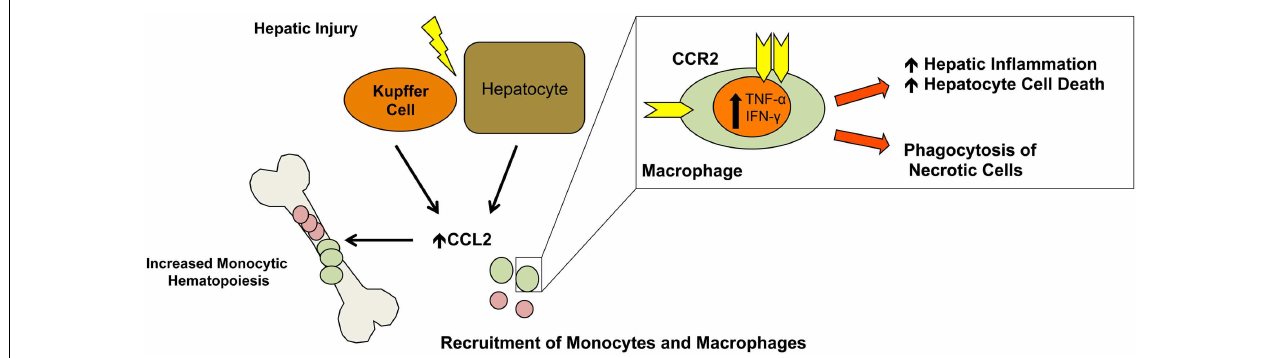
of circulating monocytes/macrophages. In the liver, macrophages secrete TNF- α and IFN- γ promoting inflammation and hepatocyte cell death while also removing necrotic cells which is important for liver remodeling and return to normal